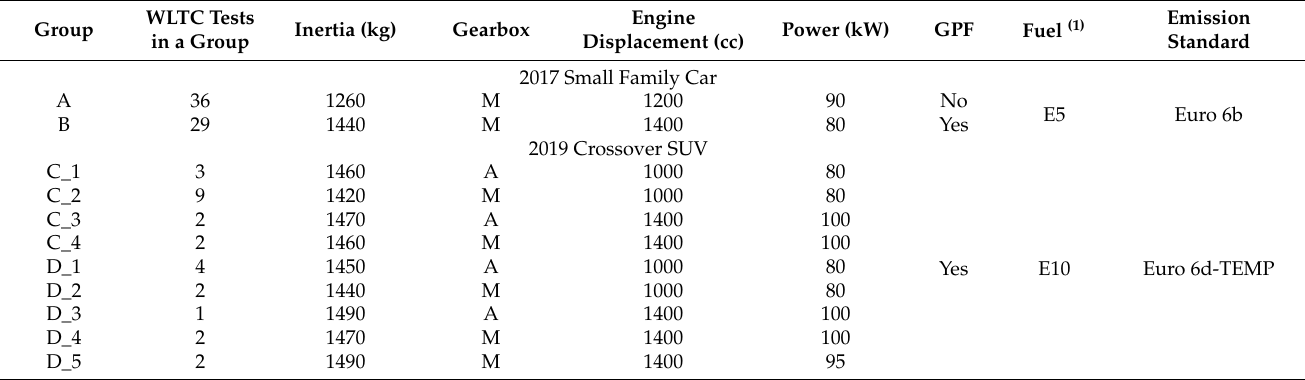
Table 4. Tested vehicles, assigned groups, number of tests, and basic